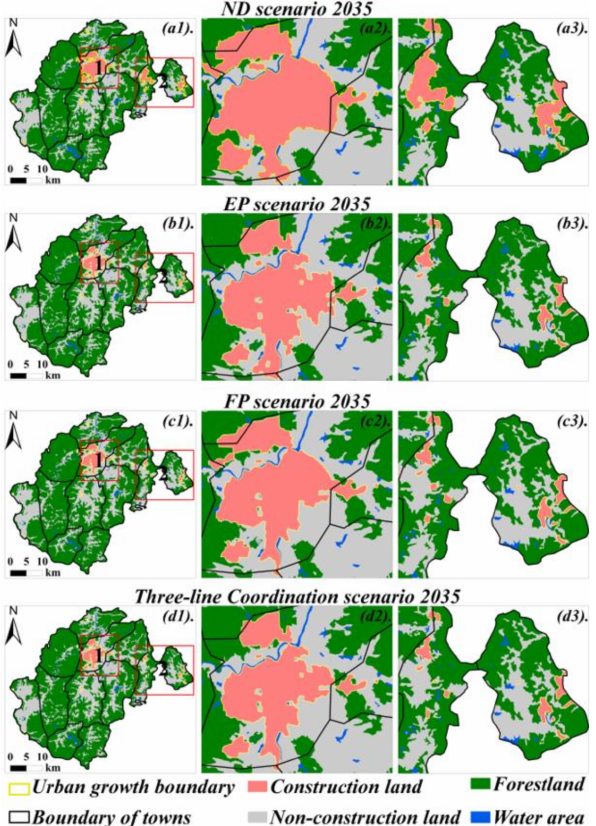
Figure 9. UGBs delineation results of Xinxing County in 2035 under different scenarios. The a2, b2, c2, d2 show the UGBs delineation of sub-region1, the a3, b3, c3, d3 show the UGBs delineation of